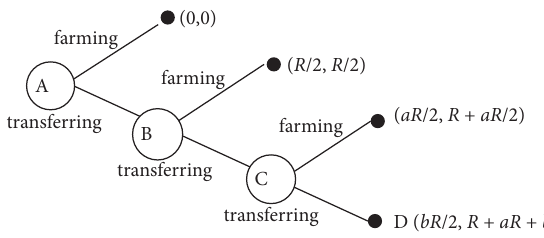
Figure 2: The expansion form of the